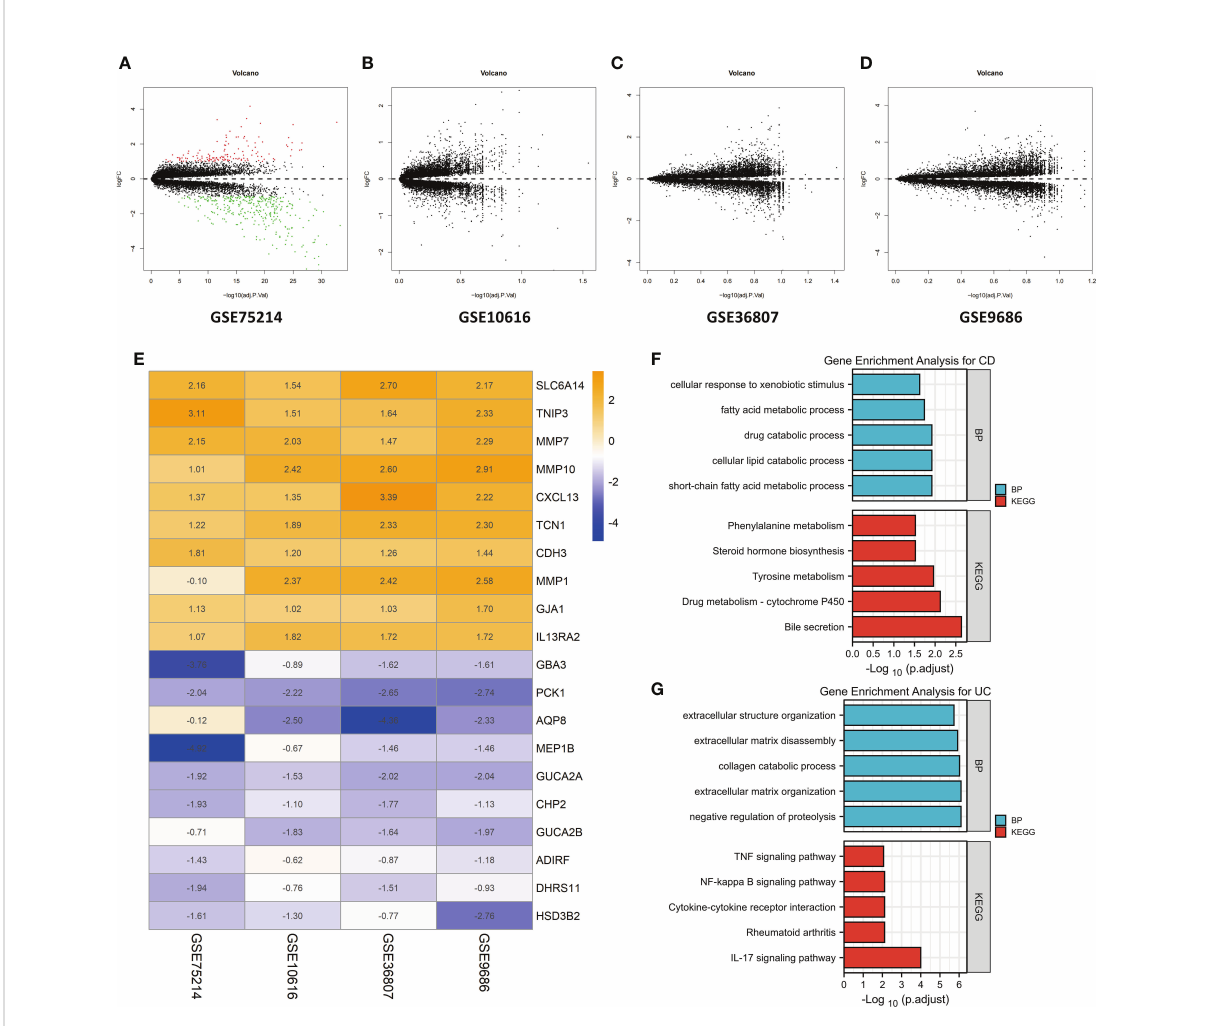
FIGURE 2 Identi fi cation of DEGs by an RRA analysis and functional enrichment analysis. Volcano plots of the DEG distributions in the GSE75214 (A) , GSE10616 (B) , GSE36807 (C) , and GSE9686 (D) datasets. Upregulated genes are indicated by red points, while downregulated genes are indicated by green points. Genes with no signi fi cant differences in levels are indicated by black points. (E) Heatmap of the expression data of the top 10 DEGs identi fi ed in the RRA. The genes upregulated in CD are indicated in blue, and those upregulated in UC are indicated in orange. Functional enrichment analysis of DEGs, including (F) a GO-BP analysis and (G) a KEGG pathway